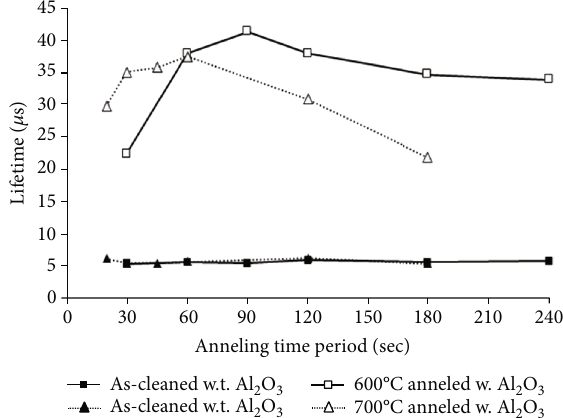
Figure 7: Lifetimes of commercial blue wafers achieved at 600 ° C and 700 ° C for various annealing time periods. A maximum lifetime of 41.15 μ s occurred at 600 ° C for 90 seconds.